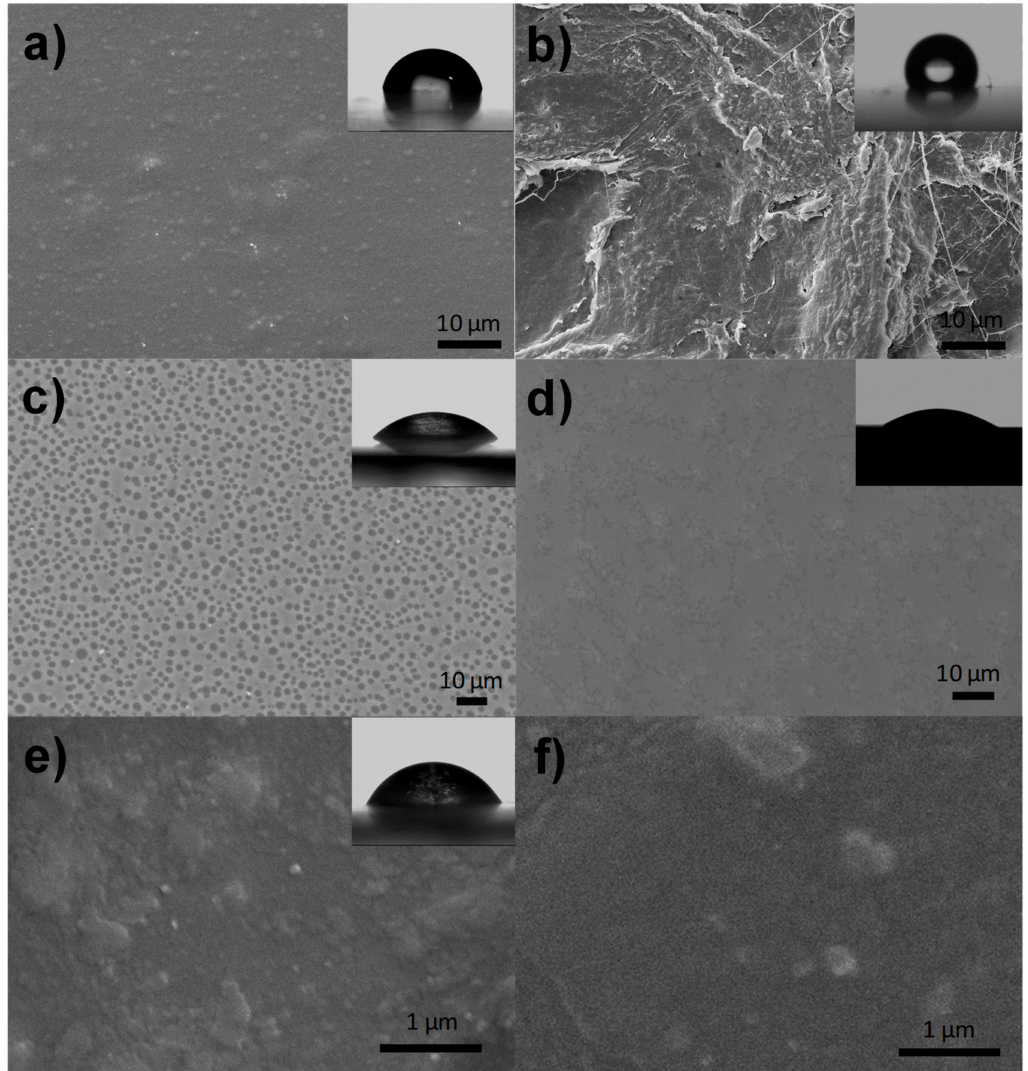
Figure 2. SEM images of the air side ( a ) and the mould side ( b ) of the polymer foil, of the air side after corona treatment ( c ), of the silica layer ( d ) and of the final device before ( e ) and after ( f ) prolonged irradiation under working conditions, together with the relative water contact angles (in insets).